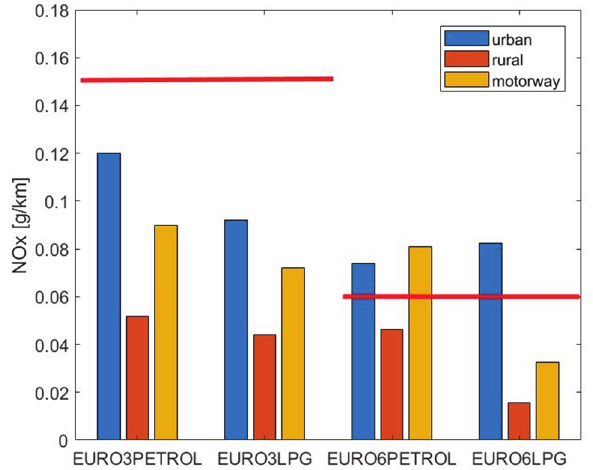
Fig, 17. Specific distance emission of NO x for selected parts of road tests (red line is emission